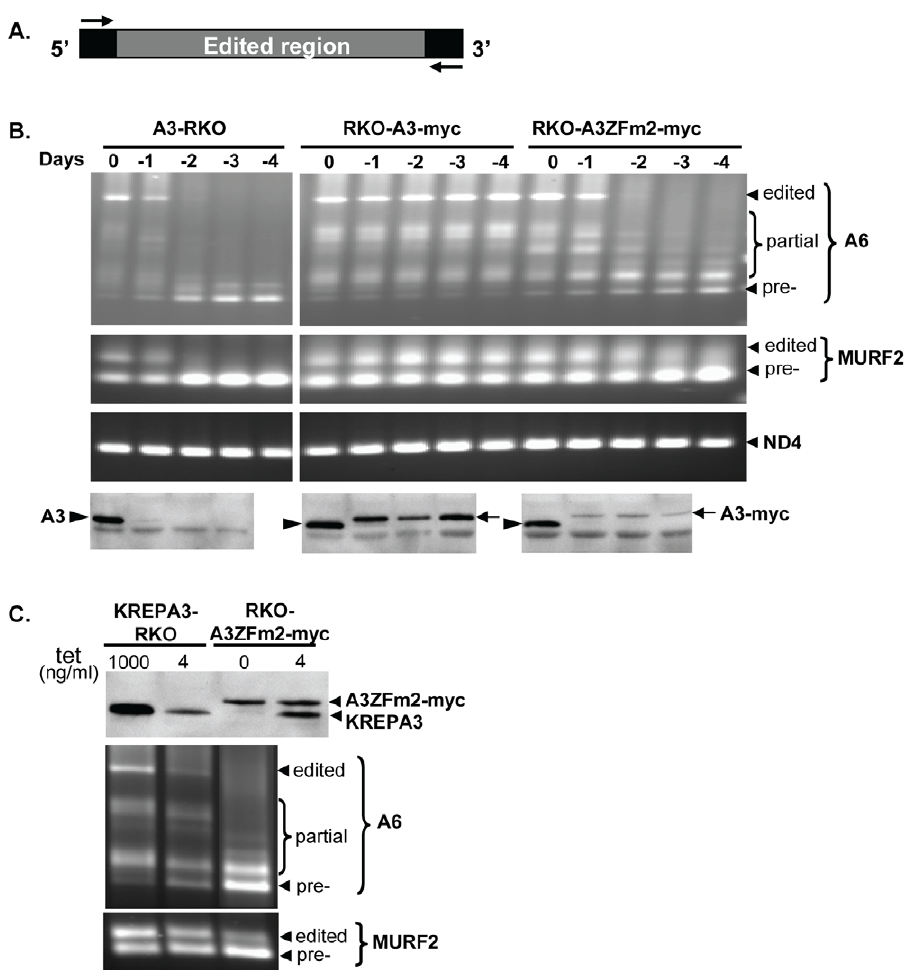
Figure 2. Partially edited A6 and MURF2 mRNAs accumulate in cells exclusively expressing KREPA3ZFm2. ( A ) Schematic showing the unedited flanking sequences used as the upstream/downstream primers for RT-PCR. ( B ) Agarose gel analysis of the RT-PCR products of A6 and MURF2 mRNAs following 1 to 4 days repression of KREPA3 Reg expression in KREPA3-RKO, RKO-A3 WT-myc and ZFm2-myc cells. The locations of the edited, partially edited, and pre-edited cDNA bands are indicated. Never-edited ND4 mRNA was used as a control. Expression of untagged and myc- tagged KREPA3 protein was monitored by Western analyses using a MAb specific for KREPA3 (lowest panel). ( C ) Comparison of the protein level of exclusively expressed KREPA3ZFm2-myc in RKO-A3 ZFm2-myc cells to the untagged KREPA3 in RKO-KREPA3 cells induced with 4 ng/ml tet by Western analysis using KREPA3 specific MAb (top panel) and agarose gel analysis of the corresponding RT-PCR products of A6 and MURF2 mRNAs (lower